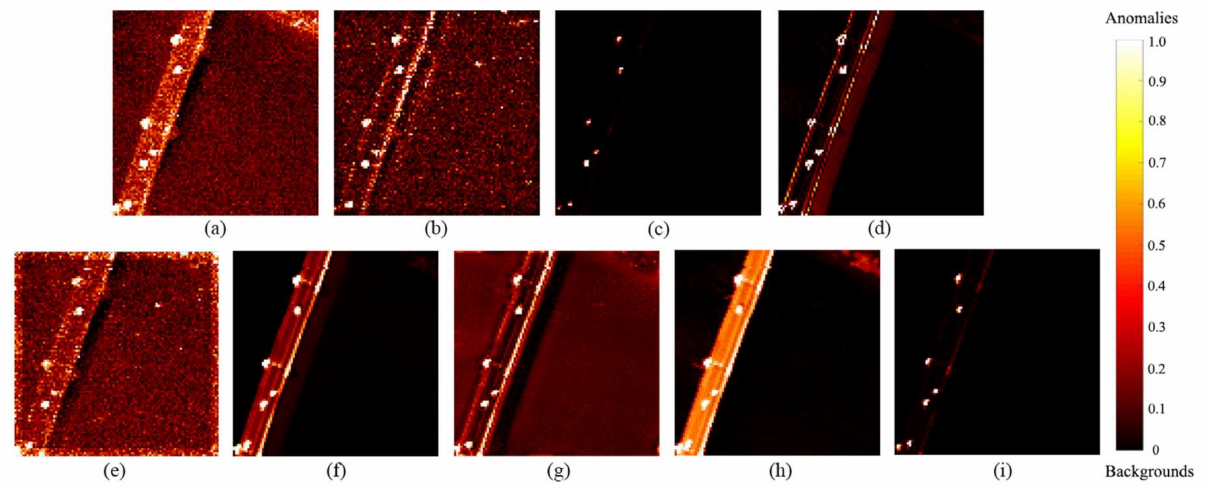
Figure 9. Detection results of various algorithms for the PaviaC Image: ( a ) RX, ( b ) LRX, ( c ) KRX, ( d ) SSRX, ( e )